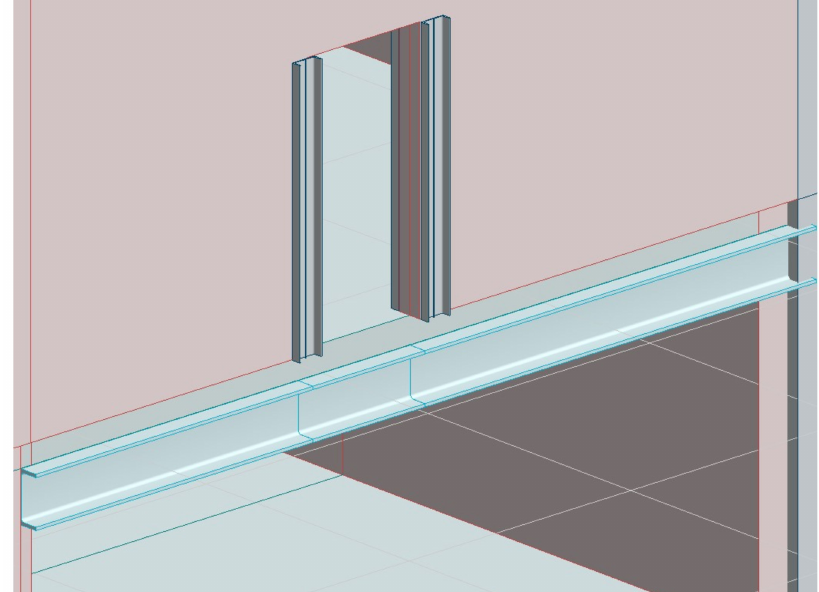
Figure 28. Modeled PSS (H2).